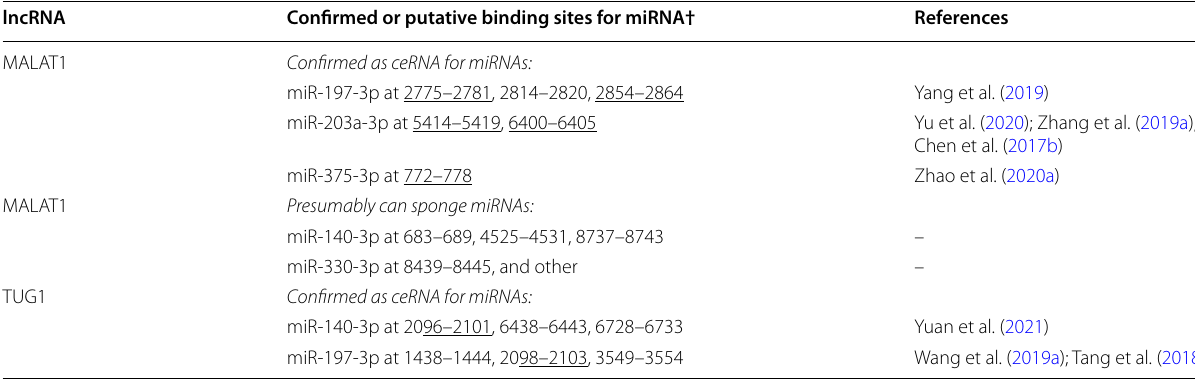
† Sites in MALAT1 and TUG1 (transcript variant 8) according to the GenBank sequence accession numbers NR_002819.4, NM_001398480.1, respectively; sites confirmed by the luciferase reporter assay are underlined